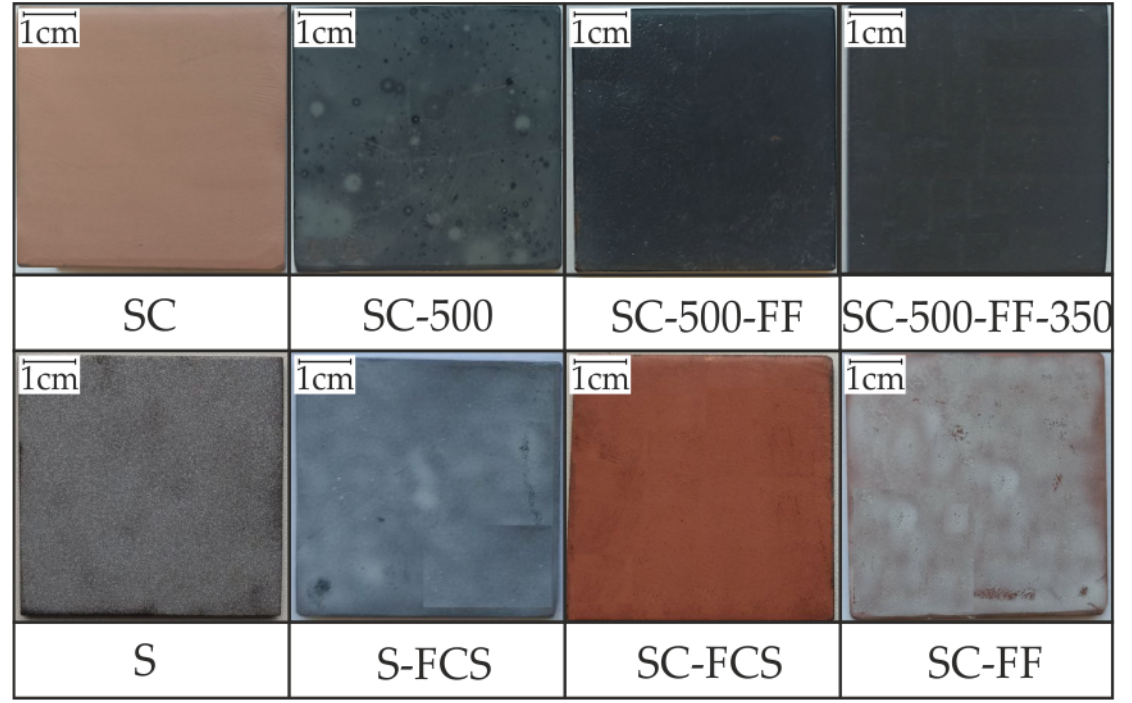
Figure 4. Images of the samples under study.